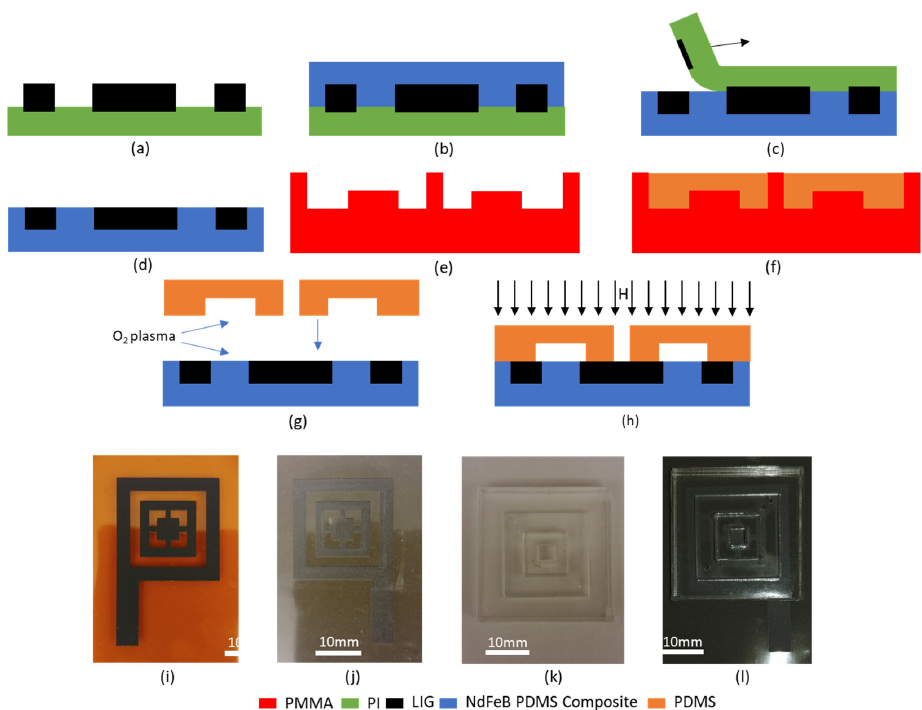
Figure 2. Fabrication of integrated MHD pump ( a ) laser-induced graphene LIG electrodes on PI, ( b ) NdFeB-PDMS composite casting, ( c ) LIG transfer, ( d ) LIG on magnetic composite, ( e ) PMMA mold fabrication ( f ), PDMS casting, ( g ) oxygen plasma treatment and bonding, ( h ) magnetization of integrated MHD pump, ( i – l ) photographs corresponding to steps ( a , d , f , h ), respectively.